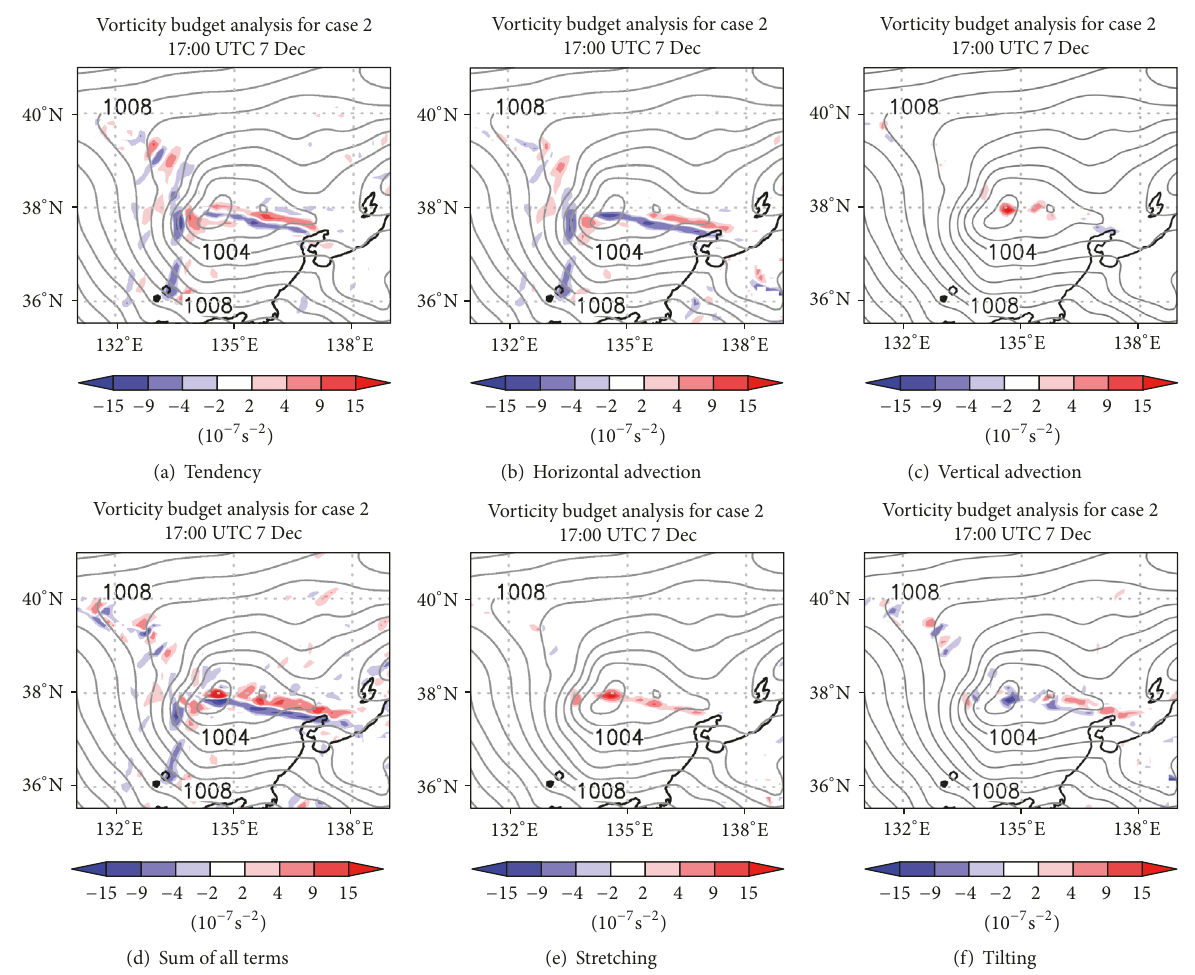
Figure 10: Results of the vorticity budget analysis in the CTL run for case 2. The selected time is 17:00 UTC on December 7. The shading denotes the spatial distributions of vorticity tendency, each budget term, and the sum of the budget terms. The SLP distribution at that time is also